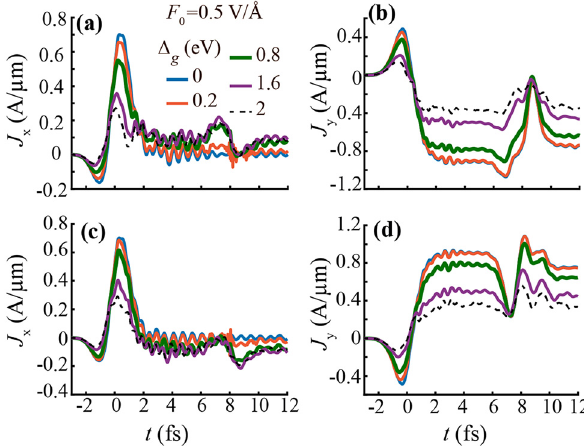
Figure 4: Electric currents J x [panel (a)] and J y [panel (b)] generated by a left-hand circularly polarized pulse (2 fs ≥ t ≥ − 2 fs) followed by a linearly polarized pulse (10 fs ≥ t ≥ 6 fs). The amplitudes of circularly and linearly polarized pulses are the same, = F = 0 . 5 V ̊ A − 1 . The corresponding band gaps are marked in F 0 1 panel (a). Panels (c) and (d) are the same as panels (a) and (b) but excited by a combination of right-hand circularly polarized pulse and a linear polarized